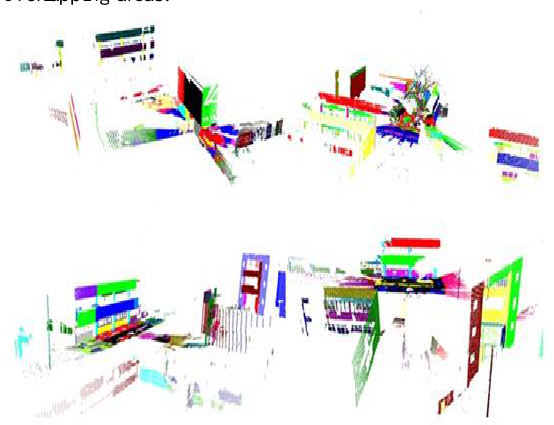
Figure 4. Segmented planes using RANSAC